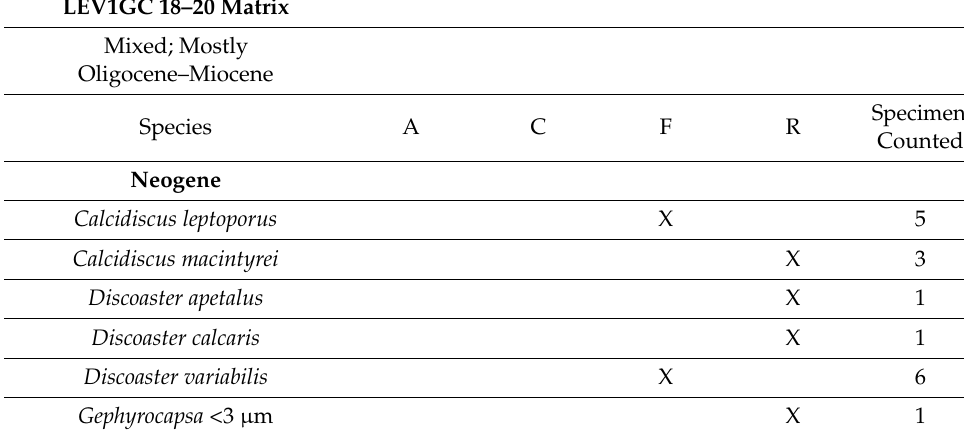
Table A9. Gelendzhik